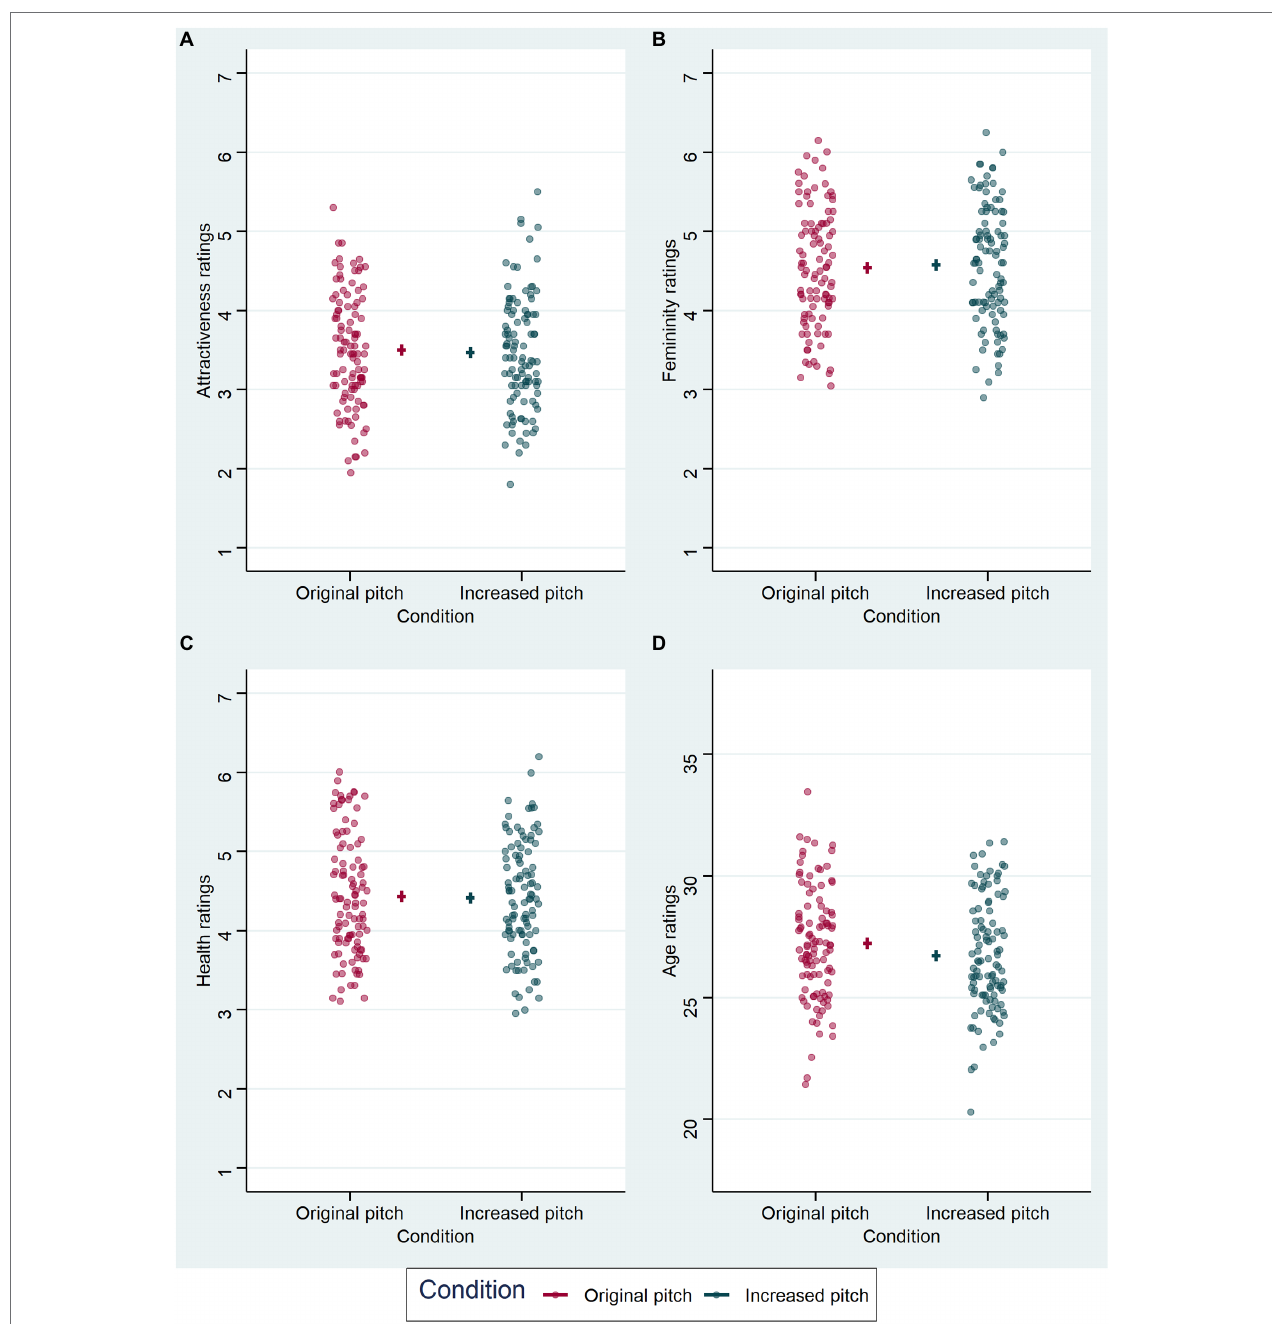
FIGURE 5 | Results from the LMM analyses of face ratings in the audiovisual block. Each graph represents the effect of voice pitch on the respective face judgment: (A) for attractiveness ratings, (B) for femininity ratings, (C) for health ratings, and (D) for age ratings (in years). Condition is indicated on the x-axis and color-coded, original voice pitch in dark pink and increased voice pitch in dark cyan. Data points (circles) represent mean values per subject and are jittered horizontally for visualization purposes. Horizontal lines show model estimate for each condition and error bars represent 95% confidence intervals of the model